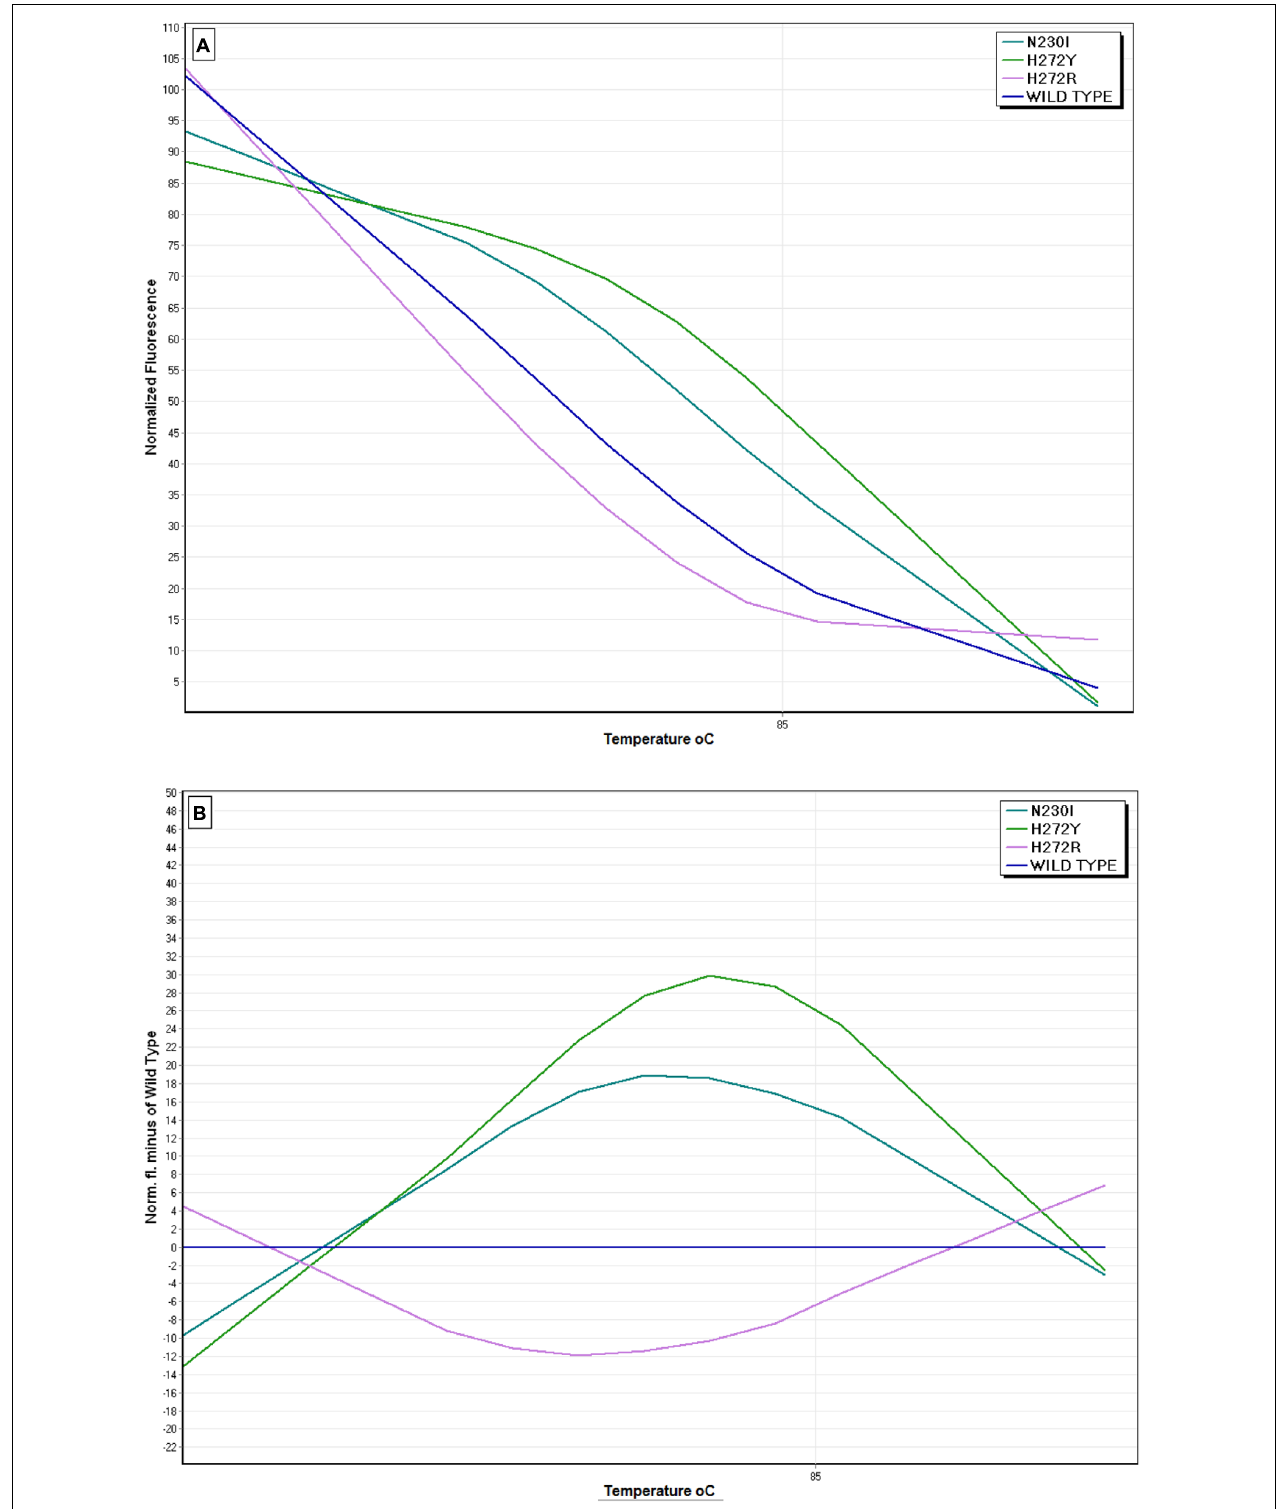
FIGURE 6 | Representative HRM analysis curves of four B. cinerea genotypes generated from unknown field samples. (A) Normalized HRM curves of DNA samples with H27R/Y and N230I mutations and one non-mutated DNA sample (wild-type), (B) Difference graph of HRM curves using the non-mutated (wild-type) sample as the reference baseline